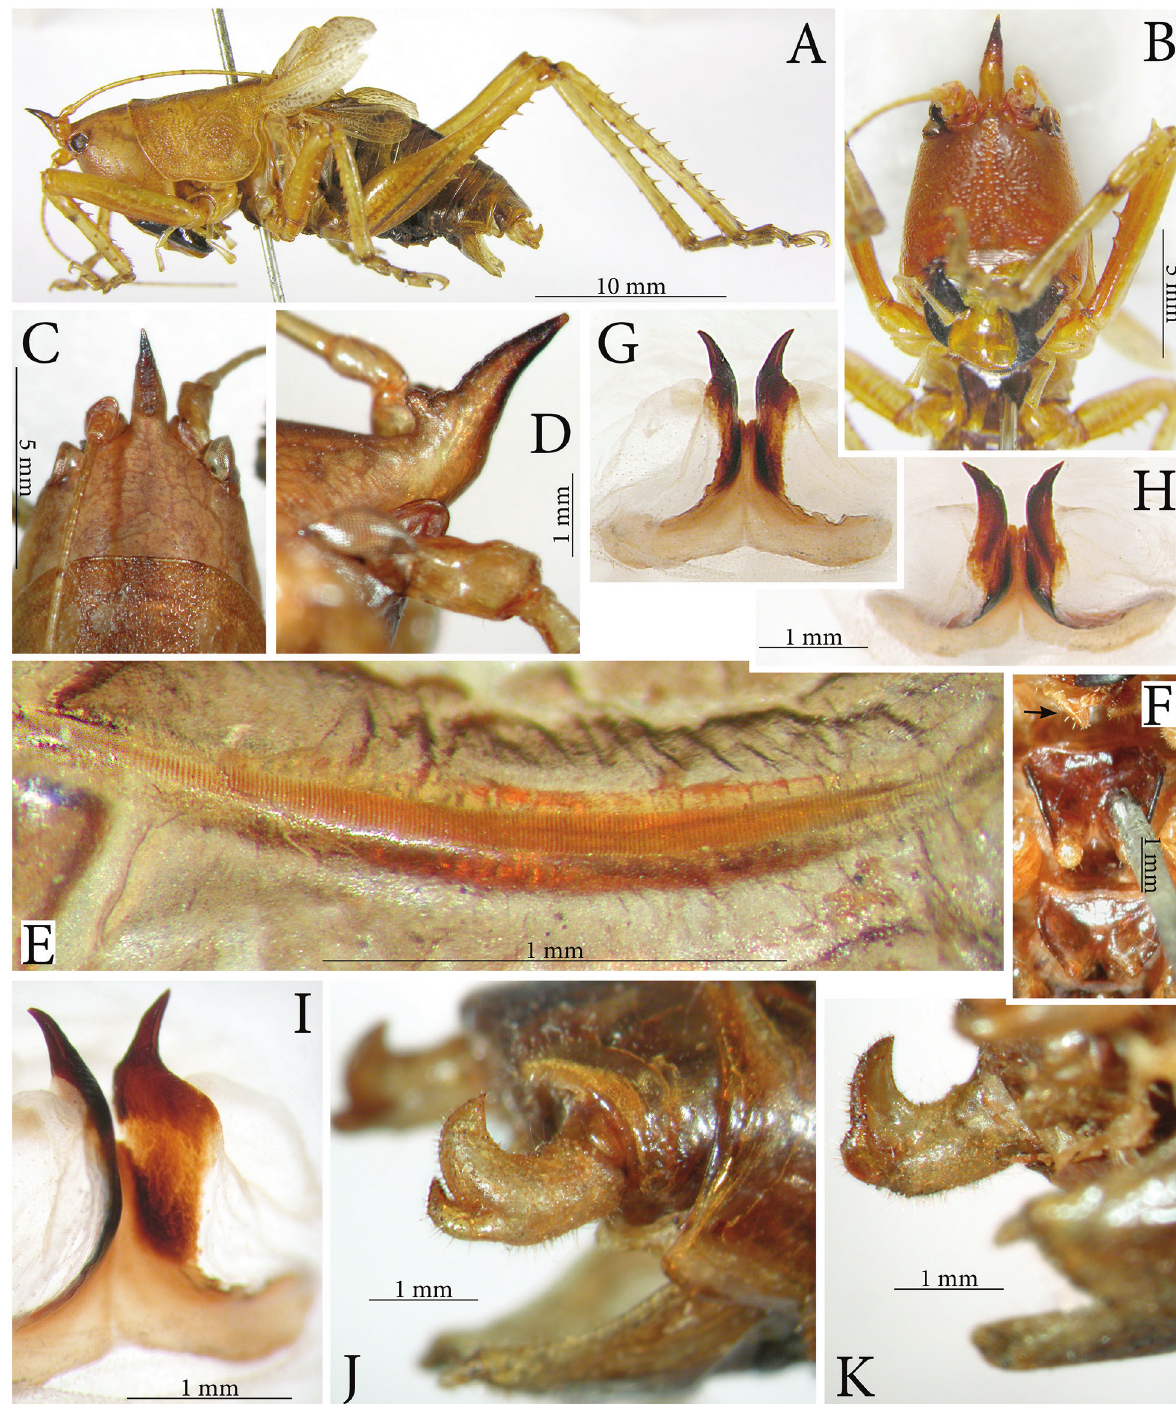
Figure 4. Liara ( Acanthocoryphus ) durata sp. nov. male holotype: A habitus lateral view; B face, C head dorsal view; D fastigium verticis lateral view; E stridulatory file on underside of left tegmen; F thoracic sternites, the arrow points at one of the prosternal spines; G–I titillators of male phallus in ventro-apical view ( G ), do. as seen from base ( H ), do. in oblique lateral view ( I ); J, K male cercus in external ( J ) and internal ( K )